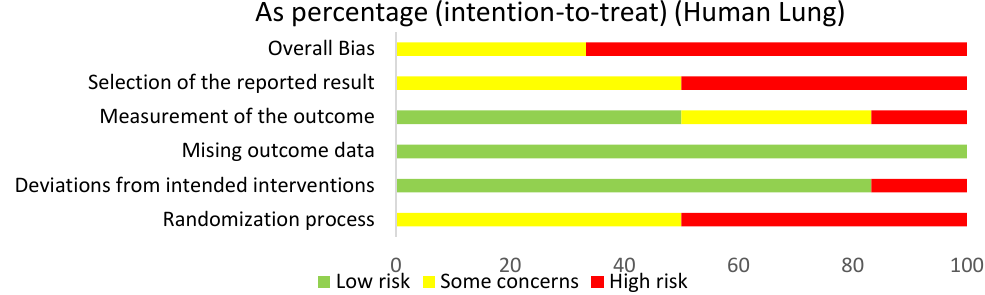
Figure 4. The overall bias for studies regarding the lung utilizing human subjects was a high risk of bias (66.7%) and some concerns (33.3%). The selection of the reported result had a high risk of bias (50%) and some concerns (50%). The measurement of the outcome had a high risk of bias (16.7%), some concerns (33.3%), and low risk of bias (50%). The missing outcome data domain had a low risk of bias of 100%. Deviations from intended interventions had a low risk of bias (83.3%) and a high risk of bias (16.7%). The randomization process had a high risk of bias (50%) and some concerns (50%).